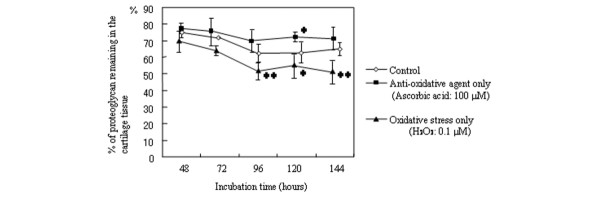
Glycosaminoglycan (GAG) remaining in the cartilage extract treated with reactive oxygen species (ROS) or antioxidative agent in tissue culture. Catabolic change in articular cartilage matrix was analyzed by determining the GAG content remaining in the cartilage extract relative to the total amount of GAG in the supernatant and the cartilage digest. Values are expressed as mean ± standard deviation of nine donors (three cartilage extracts per donor). *P < 0.05, **P < 0.01, versus control group at each incubation time.